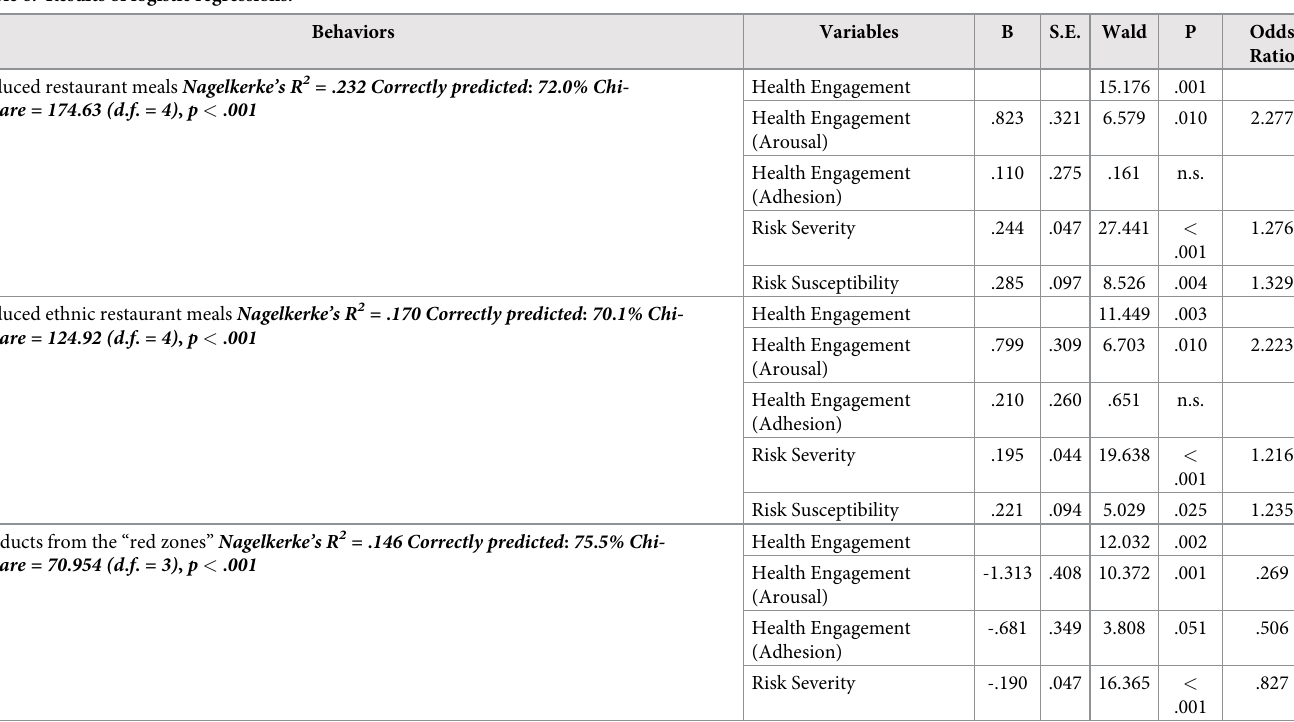
Table 6. Results of logistic